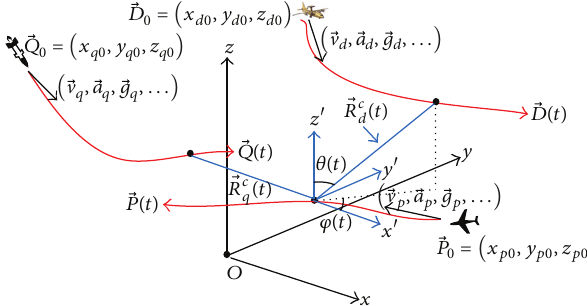
Figure 4: Bistatic missile-borne SAR